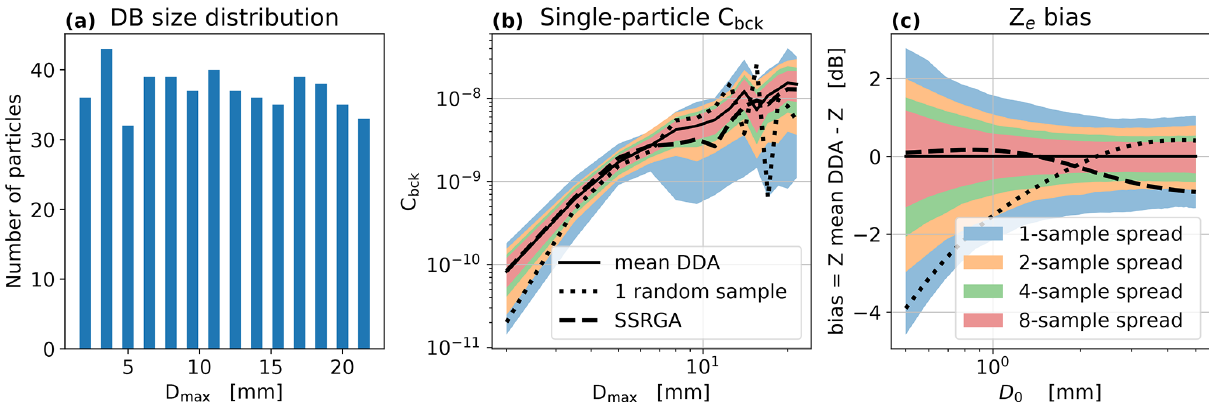
Figure 7. The uncertainty introduced by sampling the natural variability of snow properties using only a few particles to represent the whole population of snowflakes. Panel (a) shows the size distribution of snowflakes included in the reference database. Panel (b) shows the 35.6GHz backscattering cross section as a function of size for the reference database (continuous line), the SSRGA solution (dashed line), and a random sample of one particle per size bin in the DDA database. The colored areas show the 10–90th percentile variability caused by randomly sampling the DDA database with one, two, four, or right particles per size bin. Panel (c) shows the bias in the forward-simulated radar reflectivity as a function of the characteristic size D 0 of the assumed inverse exponential size